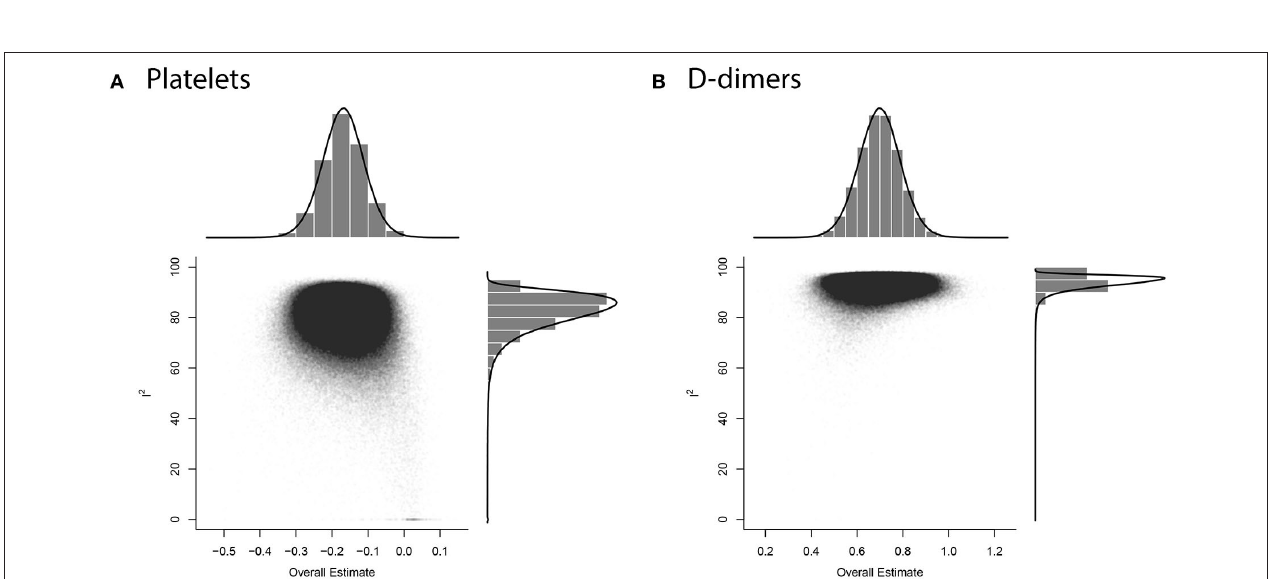
FIGURE 5 | GOSH diagnostic for influential cases in meta-analysis models (A) PLT, (B) DD.